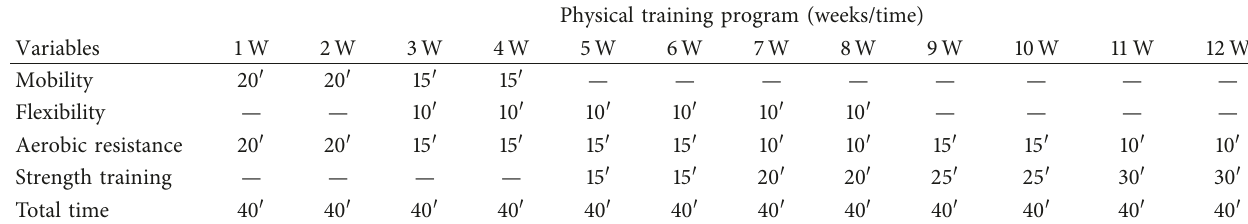
Table 1: Schematic demonstration of the weekly physical training program. Physical training program